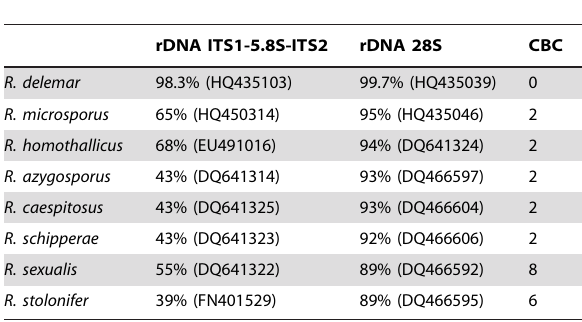
Table 4. Analysis of similarity between Rhizopus oryzae s. s. and other Rhizopus species in ribosomal DNA sequences (ITS1-5.8S-ITS2, 28S) and predicted compensatory base changes (CBC) for the ITS2